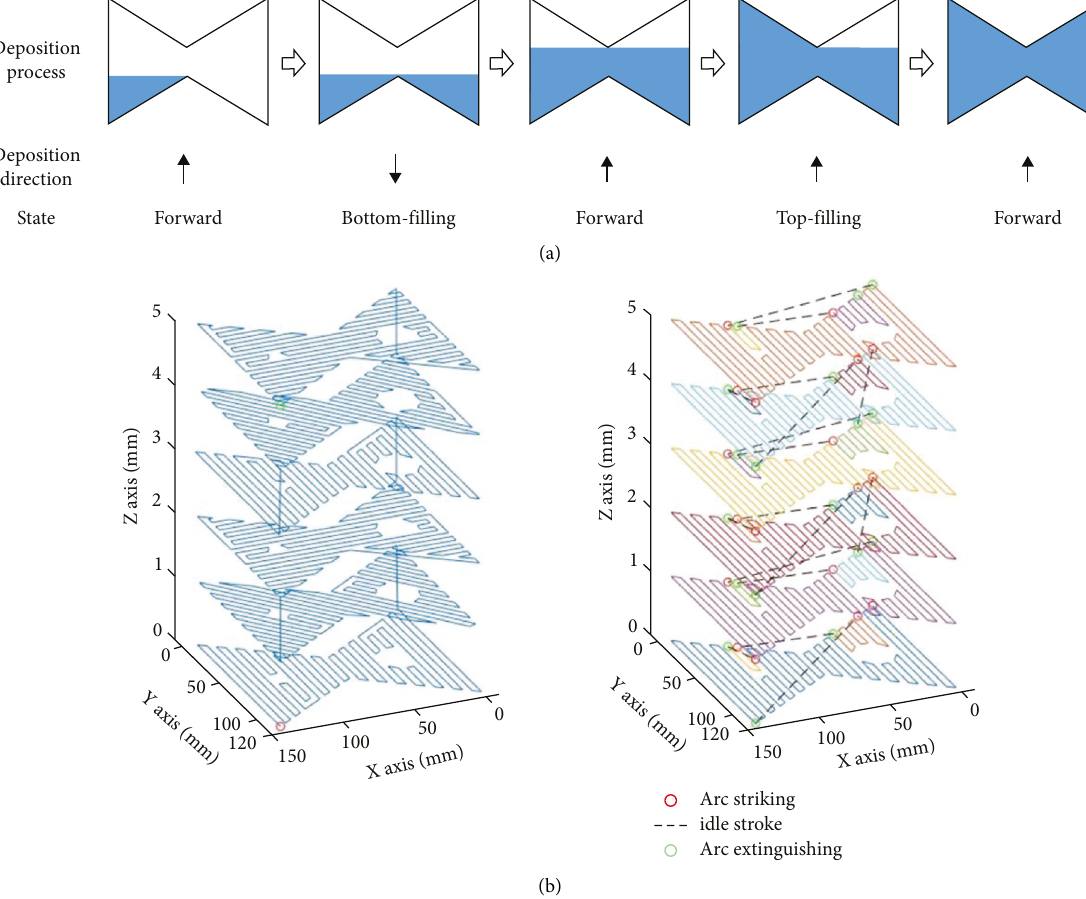
Figure 23: Planned paths of the (a) sequential water-pouring path planning method in multilayer variable direction and (b) multilayer zigzag path planning